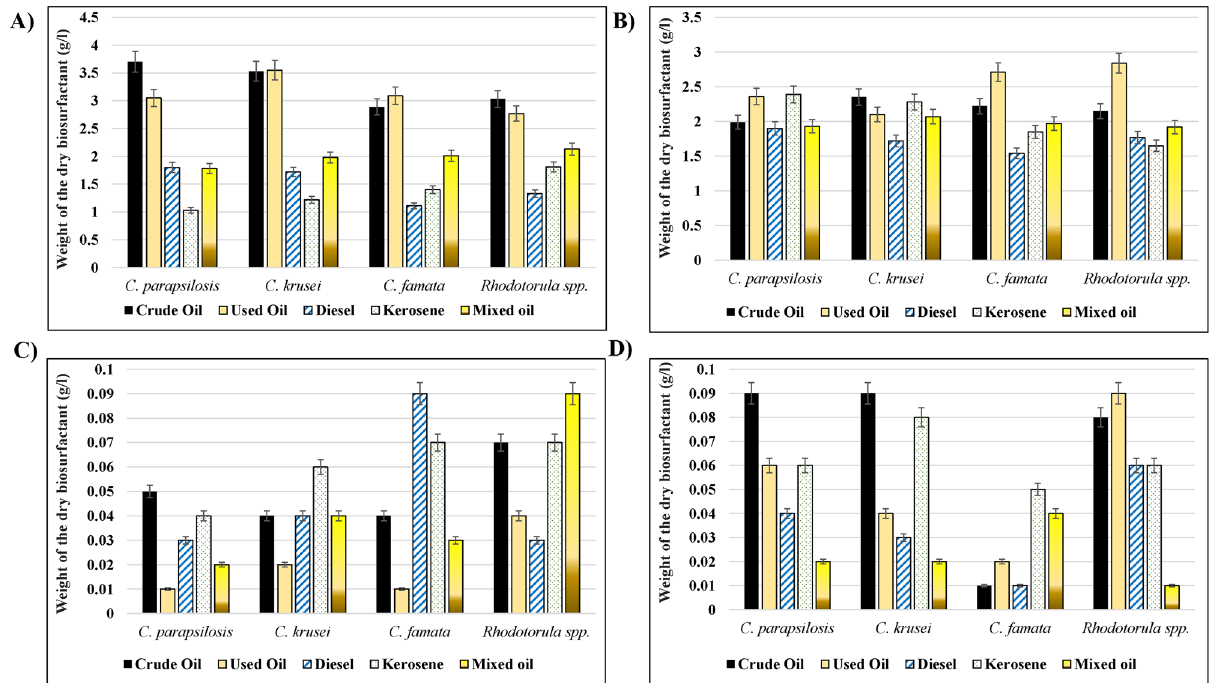
Figure 6. Biosurfactants recovery assays. The amount of biosurfactants produced by different isolated strains growing in the presence of different hydrocarbons were isolated and measured by different recovery assays. ( A ) Acid precipitation, ( B ) Solvent Extraction, ( C ) Ammonium Sulfate, ( D ) Zinc